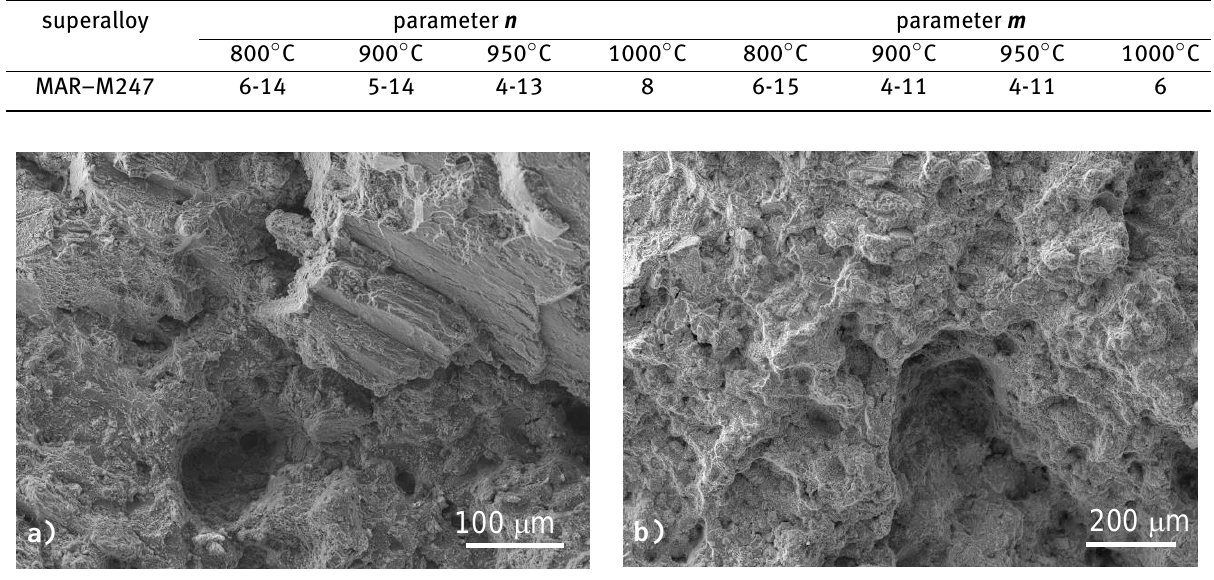
Figure 7: Fracture surfaces of creep specimen of superalloy MAR-M247 (G variant) loaded by stress 400 MPa at temperatures a) 800 ∘ C and b) 950 ∘ C.